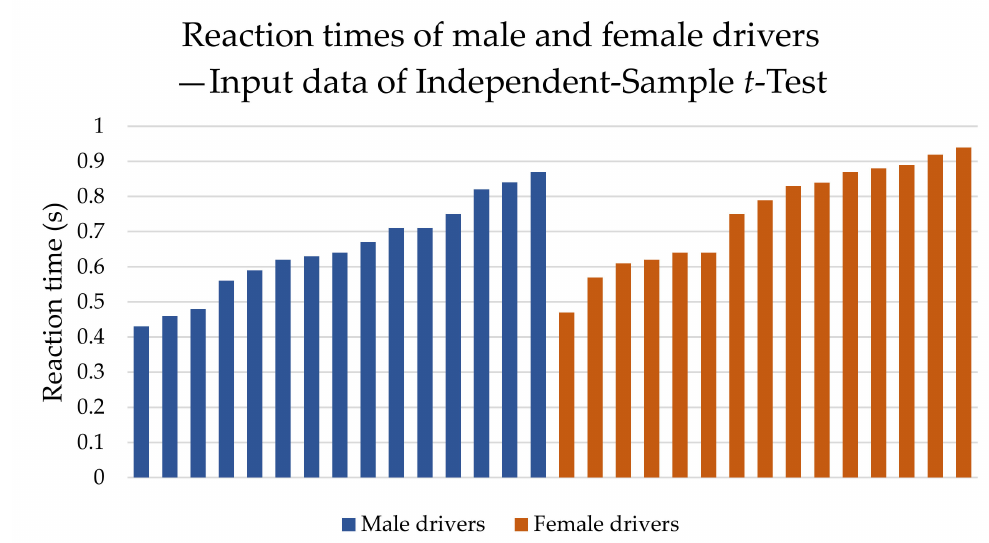
Figure 4. Input data of independent-sample t -test. Source: Processed by